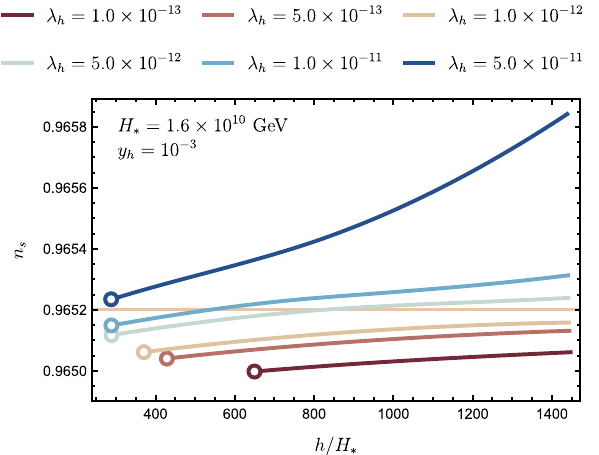
Fig. 2 The spectral index at the pivot scale k ∗ = 0 . 05 Mpc − 1 . The horizontal line indicates the central value of the Planck data [32]